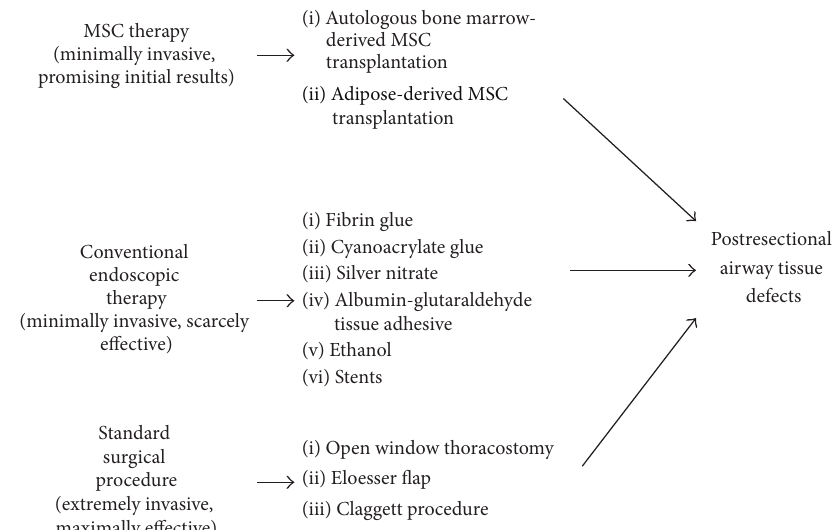
Figure 4: An algorithm showing standard, endoscopic, and MSC based therapies for postresectional airway tissue defects.